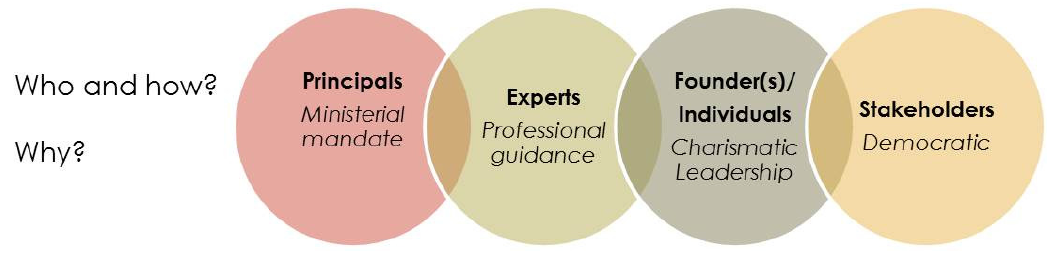
Figure 4. Strategic decision-making roles.